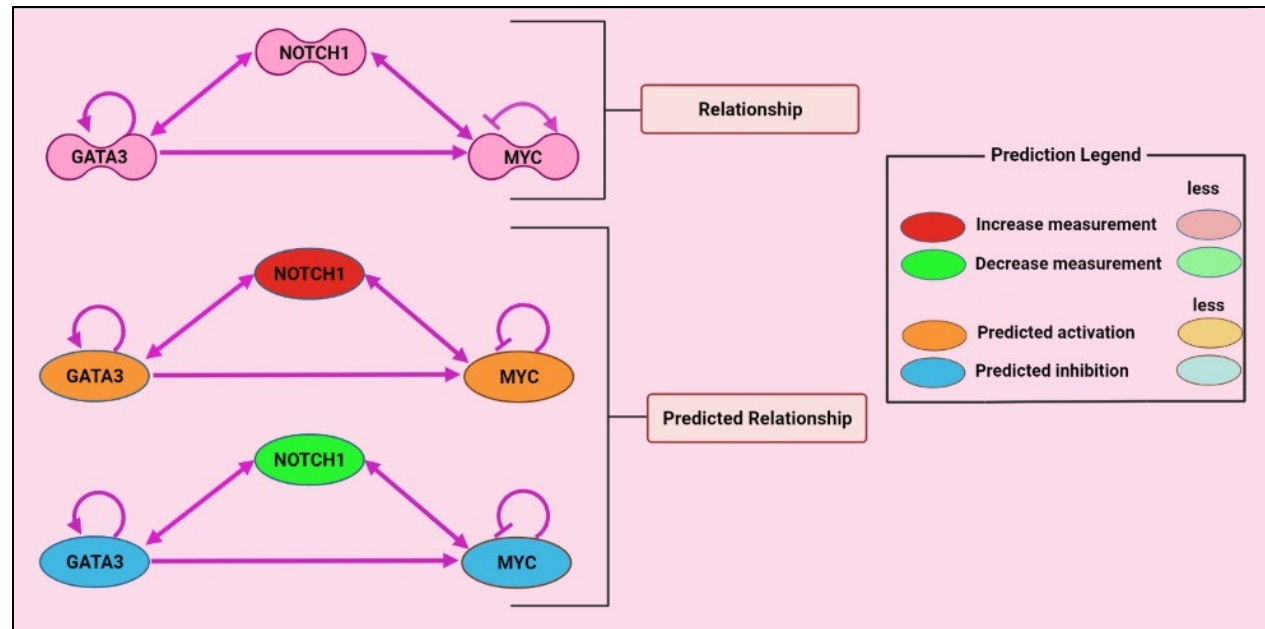
Figure 5. Relationship and predicted relationship of NOTCH1, GATA3 and c-MYC in T cell lymphoma development by using Ingenuity Pathway Analysis (IPA), QIAGEN.